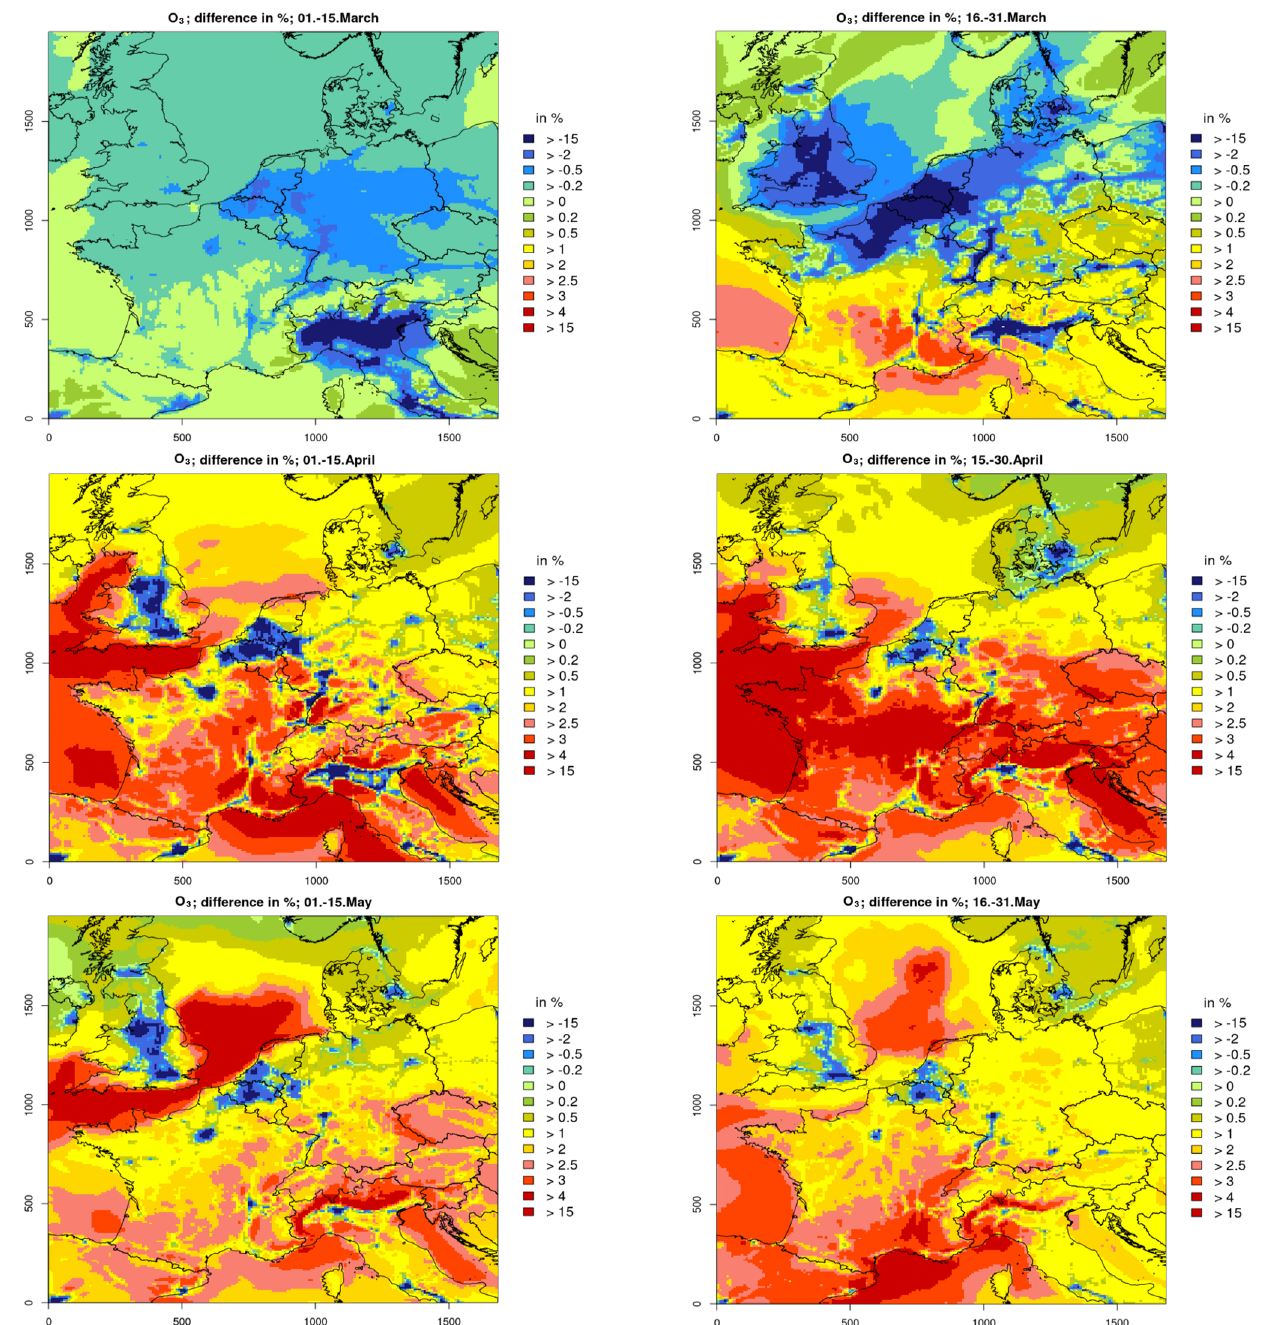
Figure A7. CMAQ results for relative O 3 concentration reductions due to lockdown measures (noCOV – COV run) in central Europe between 1 March and 31 May 2020 in half-monthly intervals; positive values denote